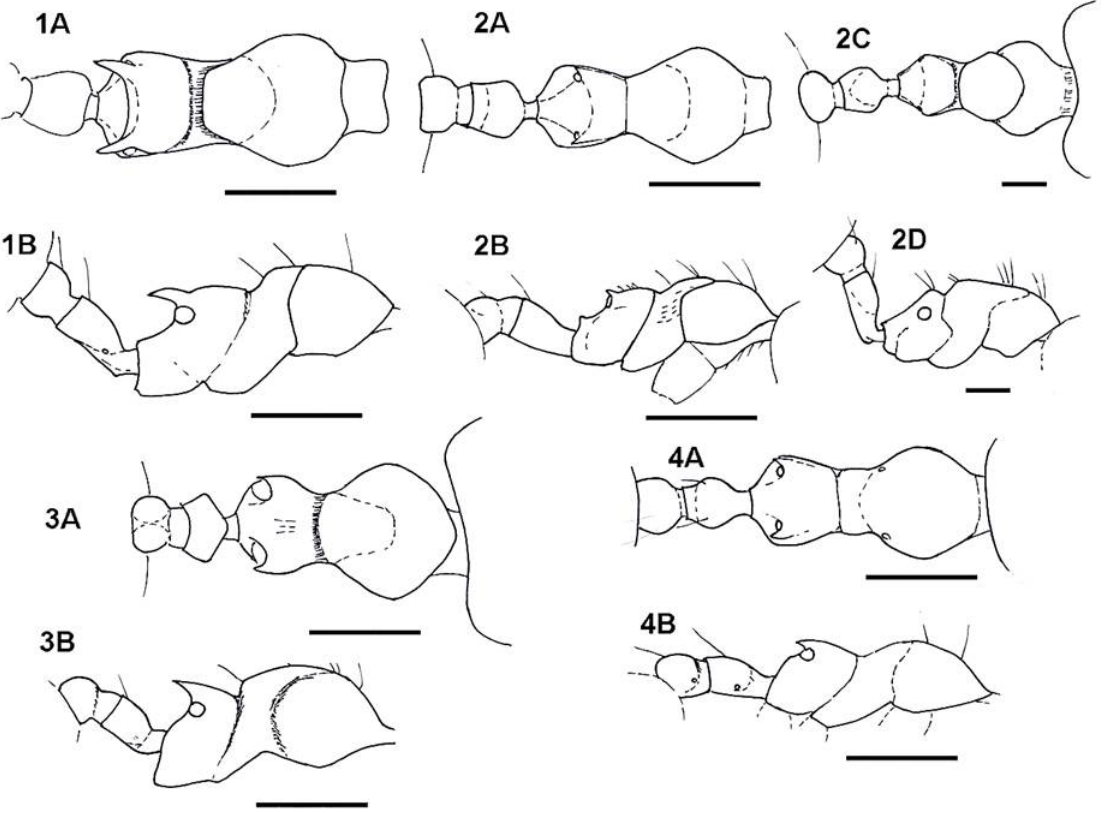
Fig S2 : Dorsal and lateral view of SE Asian Crematogaster ( Decacrema ): S2.1A and S2.1B: Crematogaster angulosa ; S2.2A and S2.2B: minor worker of Crematogaster biformis , S2.2C and S2.2D: major worker of Crematogaster biformis ; S2.3A and S2.3B : Crematogaster cephalotes minor worker; both majors and minors carry propodeal spines; S2.4A and S2.4B : Crematogaster borneensis ( Macaranga - associated). Scale bar corresponds to 0.375mm.